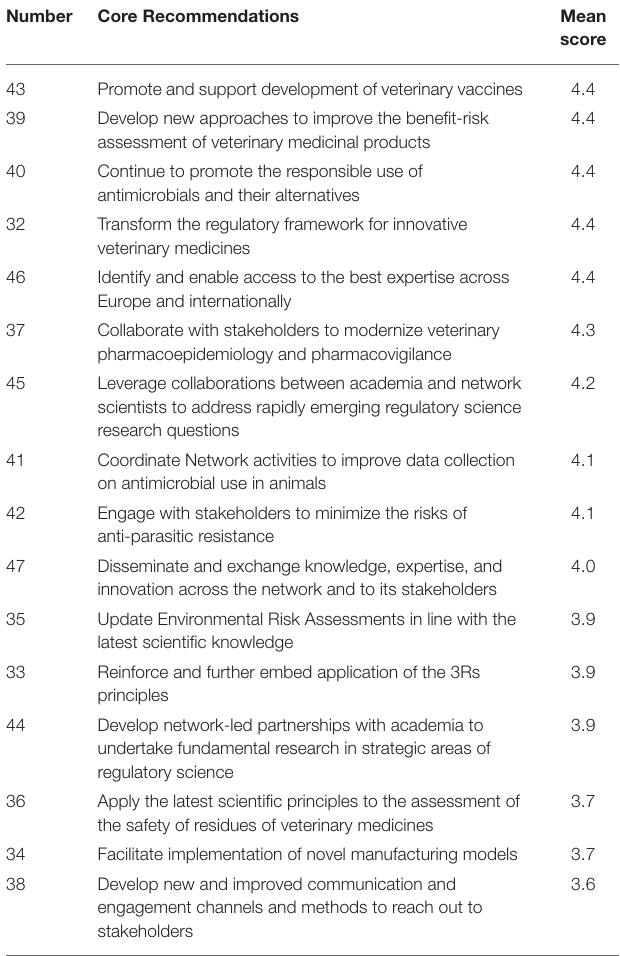
TABLE 5 | Overall comparison of all Core Recommendations by mean score (question 7, veterinary